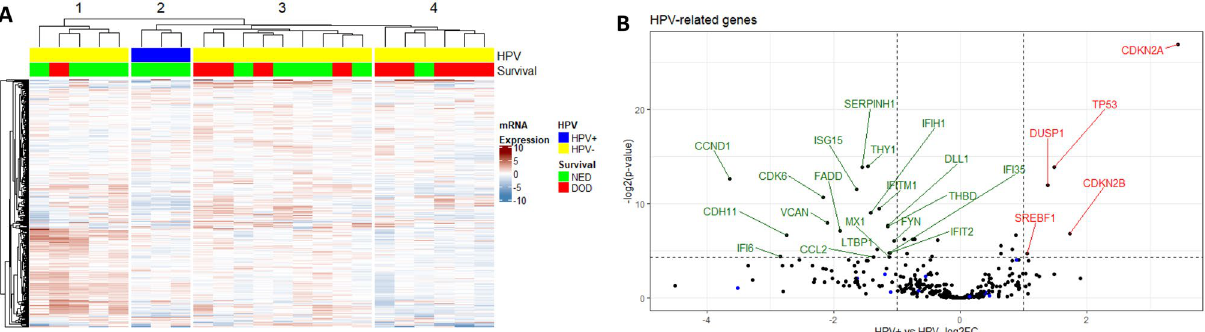
Figure 1. ( A ) Heatmap of all samples. Genes are rows and samples columns. (NED = No evidence of disease, DOD = dead of disease). ( B ) Volcano plot of transcripts differing between HPV-positive and HPV-negative samples. Transcripts higher in HPV-positive samples are marked red. The horizontal line indicates adjusted p value of 0.05. Blue dots represent genes in the tumor inflammation signature. Analyses of mRNA expression were performed in R 3.6.2. Heatmaps were plotted with the R package ComplexHeatmap 40 . (https ://www.bioco